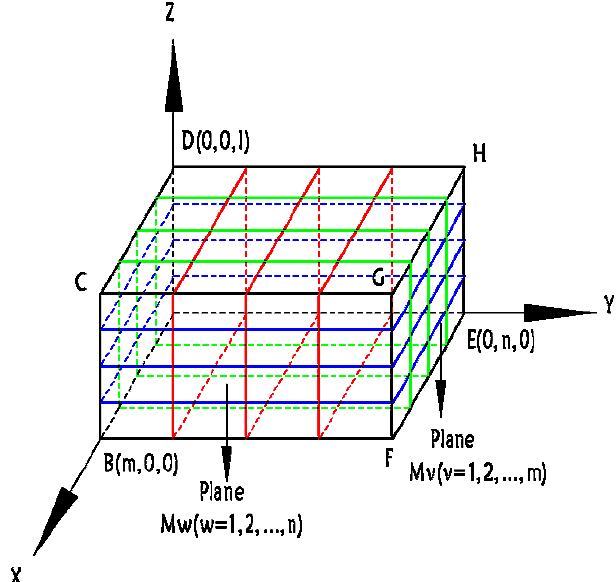
Figure 6. Grid method to divide three-dimensional space.